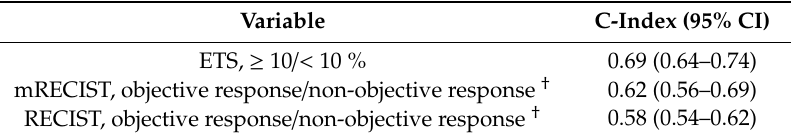
Table 6. The discrimination abilities on